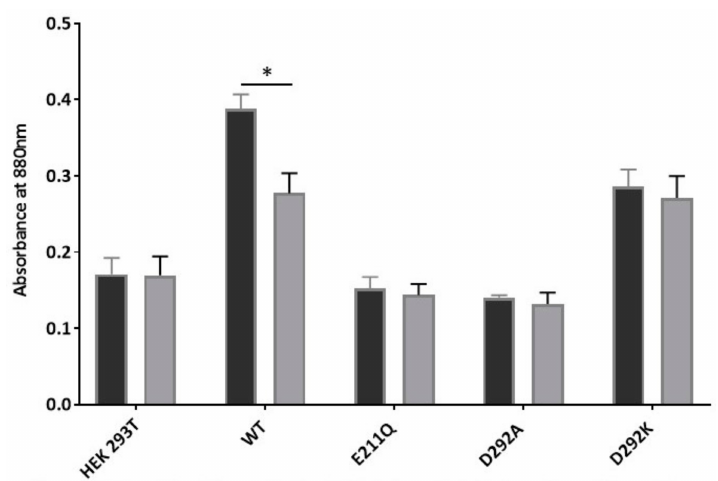
Figure 5. ATPase activity of transport-inactive NBD interface mutants. Crude membranes (20 µ g protein) were incubated with lucifer yellow (100 µ M; dark bars bar) in absence or presence (light bars) of Ko143 (1 µ M). The results show that ATP-specific Pi measured by colorimetric determination of phosphomolybdate complexes. Only WT ABCG2 demonstrates a level of Pi release which is inhibited with Ko143 (* p < 0.05), demonstrating ABCG2 specific Pi release, confirming that D292A and D292K are ATPase deficient